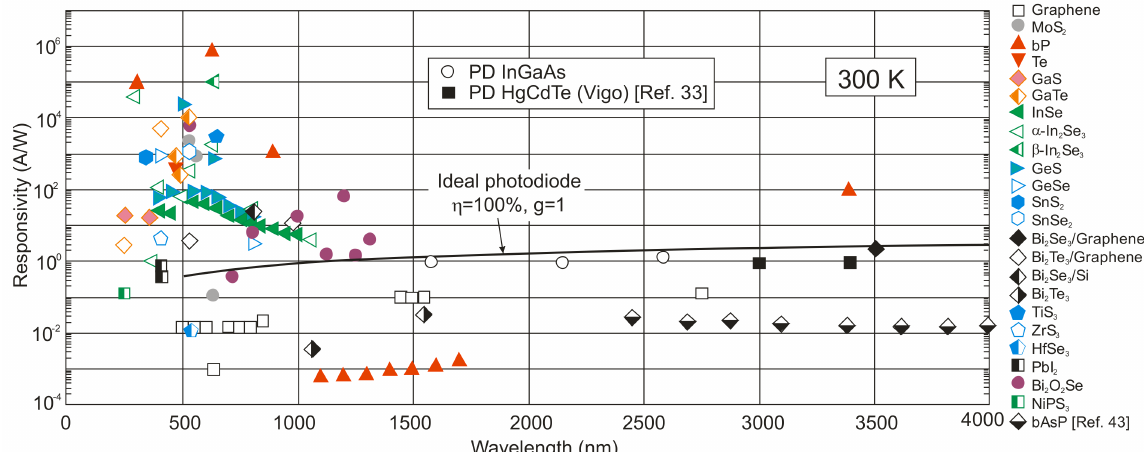
Figure 16. The layered 2D material photodetectors spectral responsivities at 300 K (after reference [43,61]). Black line shows spectral responsivity for ideal photodiode with 100% QE and g = 1. The responsivities of commercially available photodetectors (InGaAs and HgCdTe photodiodes) are presented for comparison reasons.